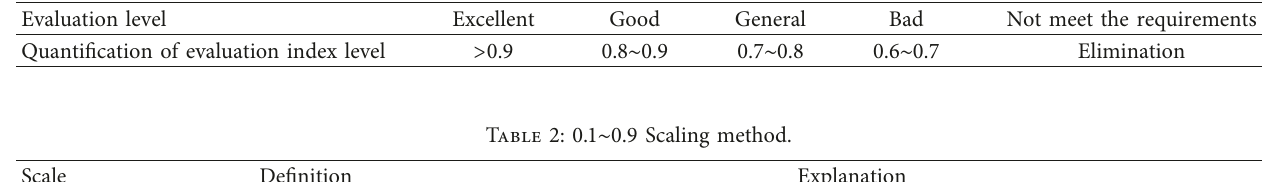
Table 1: Quantification of evaluation level.